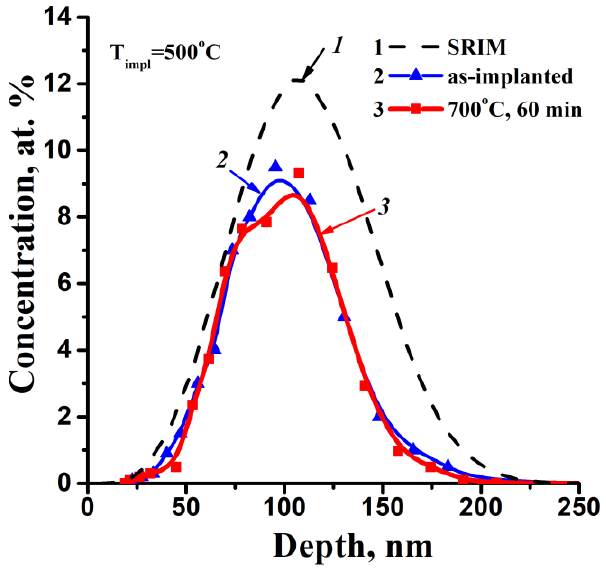
Figure 1. Simulated (SRIM-2013) (curve 1) and calculated from RBS spectra depth profiles of impurity concentration in SiO 2 after Zn + implantation (150 keV, 7.5 × 10 16 cm −2 ) (curve 2) and subsequent annealing at 973 K (700 °C) for 60 min (curve 3).